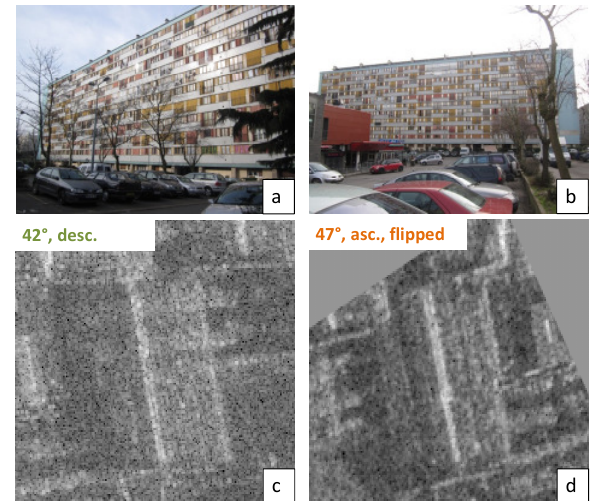
Figure 7: Outlook about radargrammetric processing with opposite-side configurations; a, b) pictures of opposite building façades; c) master image (desc. 42°); d) flipped slave image (asc. 47°), coregistered on master